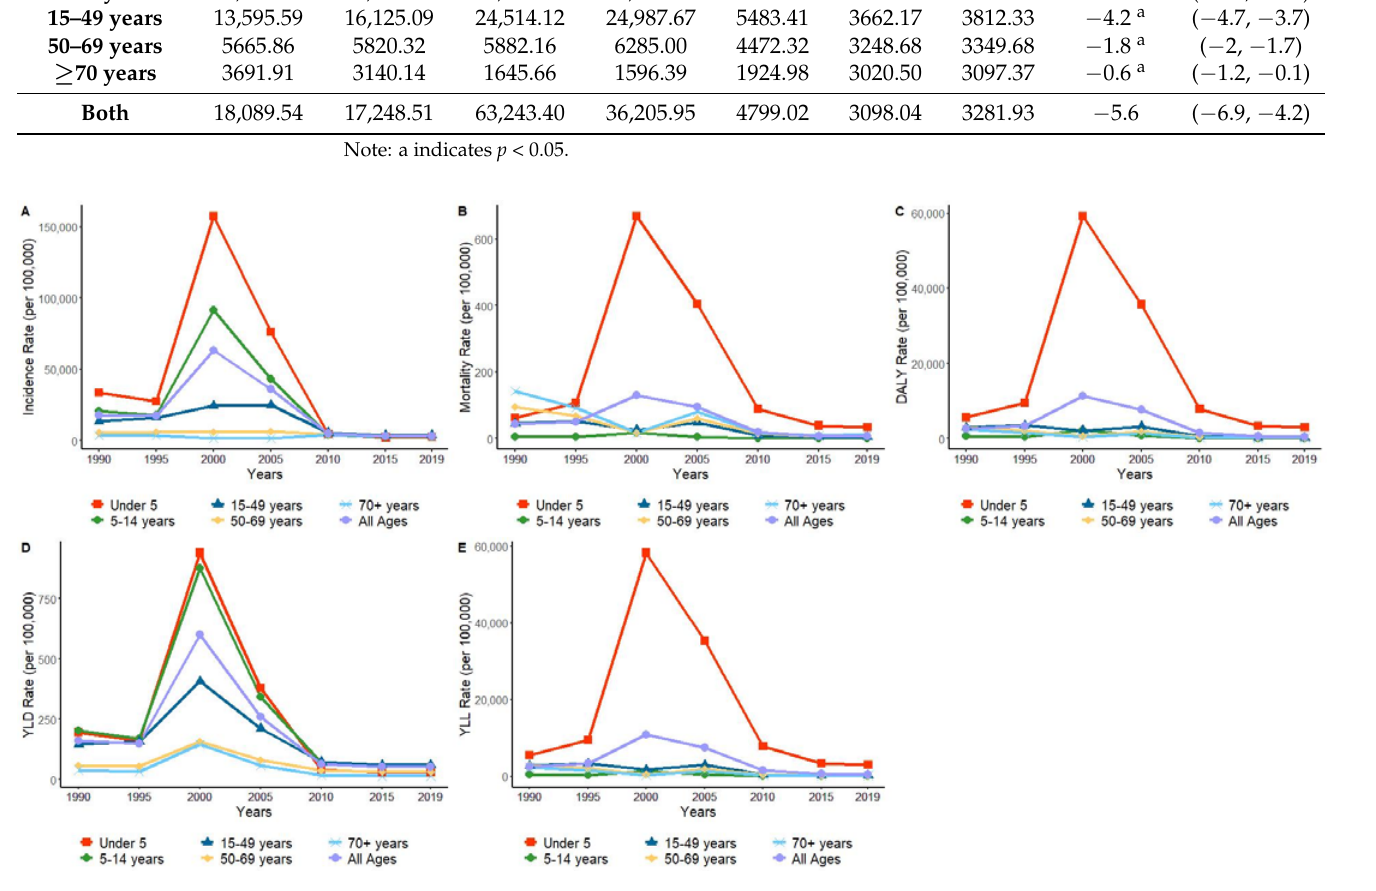
Figure 9. Age-standardized rates per 100,000 inhabitants from 1990 to 2019. Note: ( A ) Incidence, ( B ) Mortality, ( C ) DALYs, ( D ) YLDs, and ( E ) YLLs per 100,000 inhabitants from 1990 to 2019. Table 3. Changes in mortality of malaria per 100,000 population by age group in STP, 1990–2019.